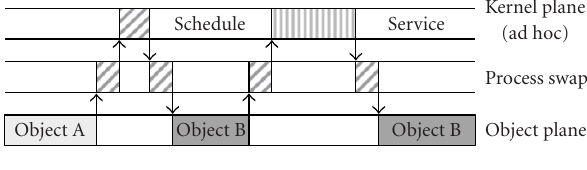
Figure 6: Overhead sources in